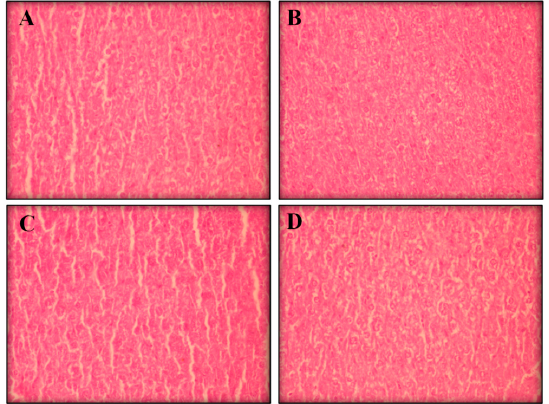
Figure 3. The effect of perillaldehyde 8,9-epoxide on livers of healthy mice. Histopathology was analyzed by light microscopy and stained with hematoxylin-eosin (400×). Photos from liver represent negative control ( A ); positive control 25 mg/kg/day 5-FU-treated ( B ); 100 mg/kg/day perillaldehyde 8,9-epoxide treated ( C ); and 200 mg/kg perillaldehyde 8,9-epoxide treated ( D ).